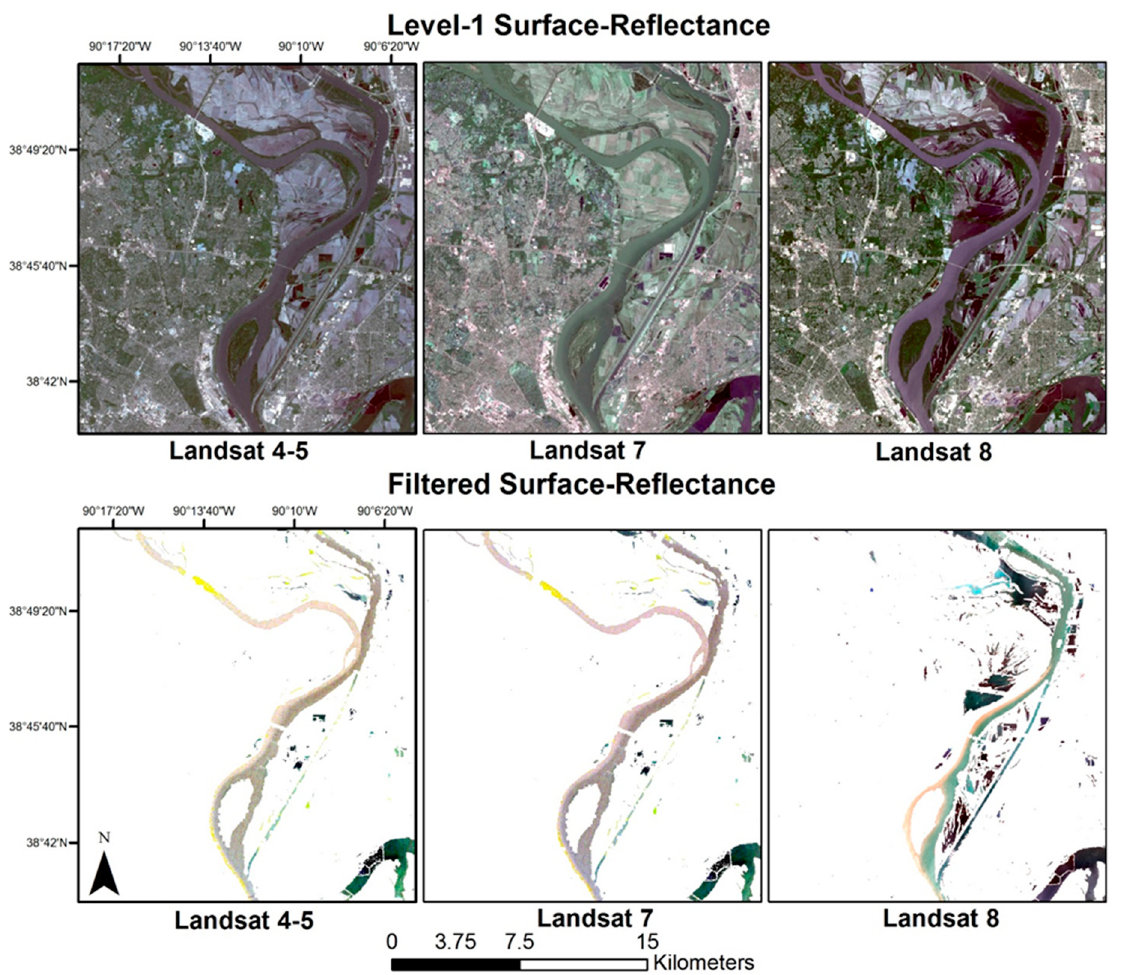
Figure 2. Examples of the Landsat image filtering process near the confluence of the Missouri and Mississippi rivers. The top panel displays the level-1 surface reflectance for each Landsat sensor and the bottom panel the resulting surface reflectance after the filtering process. All images are visualized in RGB bands.